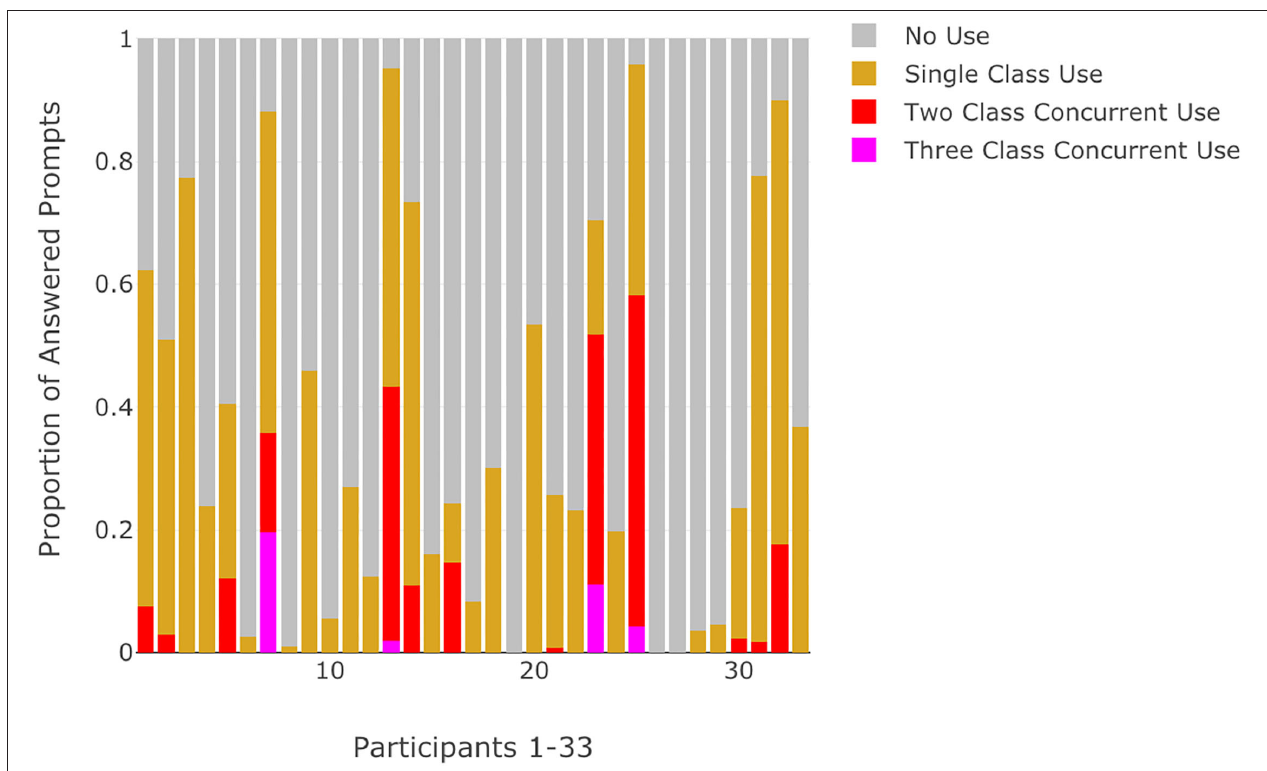
FIGURE 4 | Proportion of answered prompts categorized by no use, single substance class use, or multiple concurrent substance use for each participant.